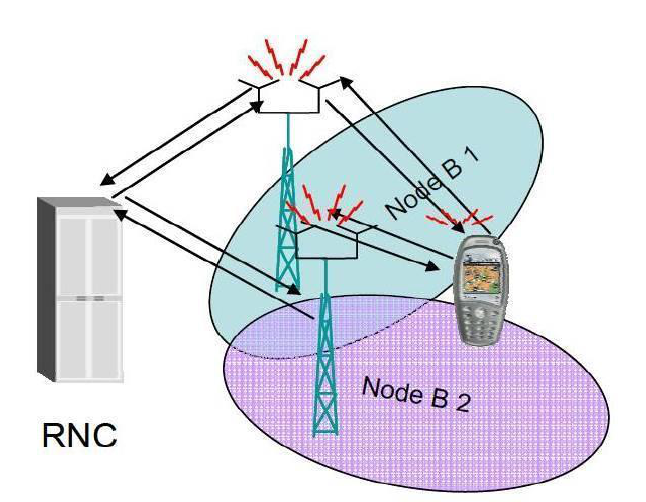
Fig. 1. Mechanism of soft handover [Soft and Softer handover technology,